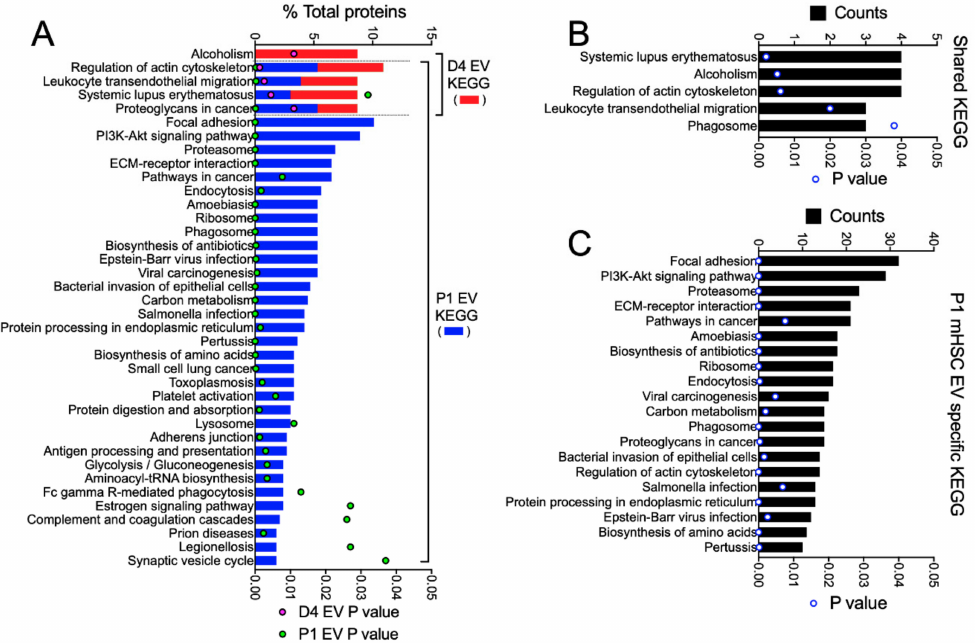
Figure 6. KEGG pathway analysis of proteins in EVs from D4 and / or P1 mHSC. EV proteins were analyzed online using DAVID v6.8 software for KEGG pathway analysis. The figure shows pathways that were ( A ) in the entire mHSC EV proteome from D4 mHSC versus P1 mHSC; ( B ) shared between EVs from D4 and P1 mHSC; or ( C ) specific to P1 mHSC EVs (top 20 pathways shown). Only pathways with significant enrichment ( p < 0.05) are